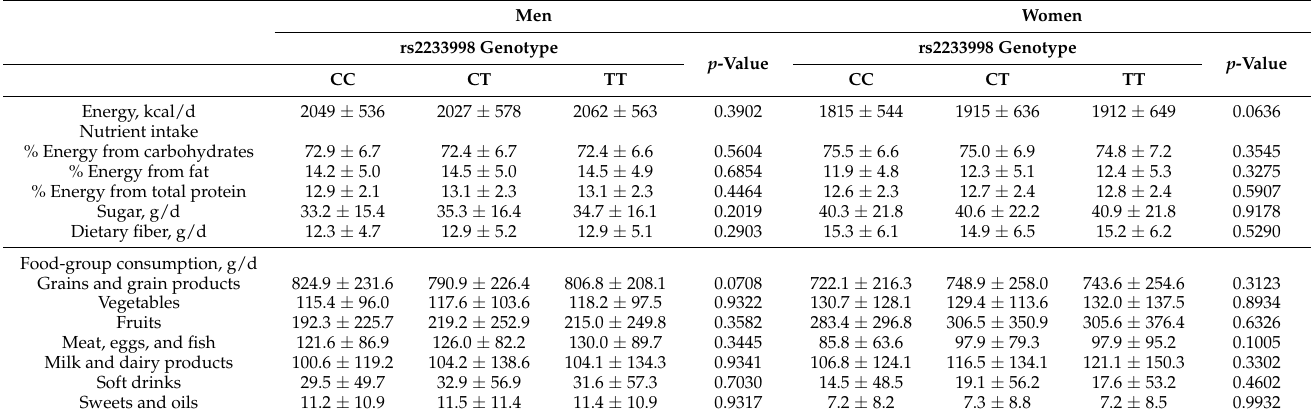
Table 2. Nutrient and food-group intake according to TAS2R4 rs2233998